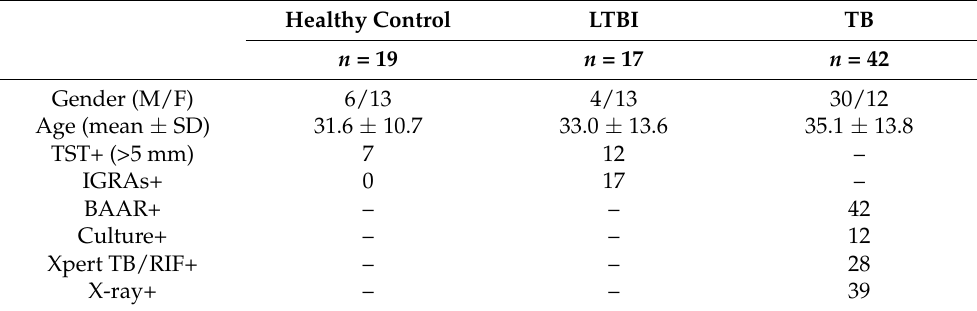
Table 1. Clinical profile of healthy control, latent tuberculosis infection (LTBI), and active tuberculosis (TB) groups recruited at Hospital Presidente Vargas (S ã o Lu í s, Brazil) from 2019 to 2020. Healthy Control LTBI TB n = 19 n = 17 Gender